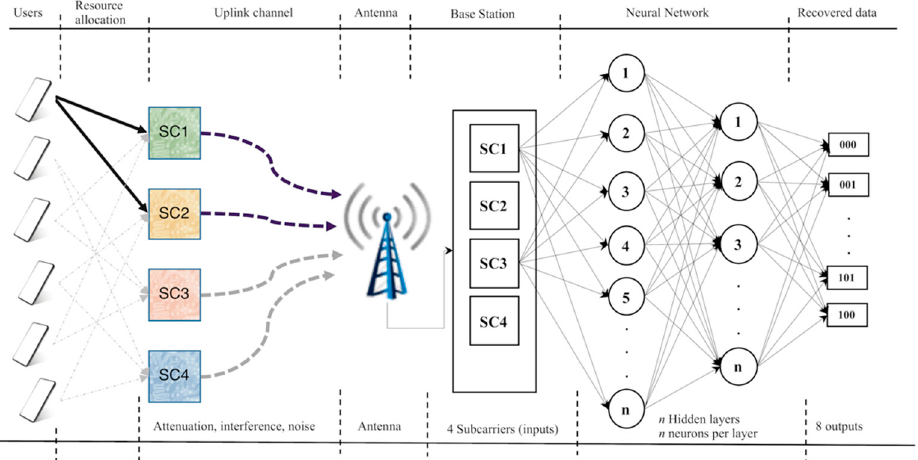
Figure 3. Neural network-based receptor diagram.